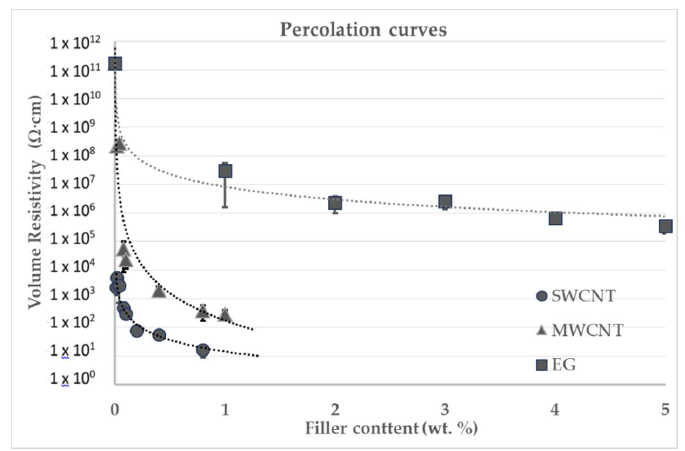
Figure 4. Electrical percolation curves of the epoxy nanocomposites prepared with the selected carbon nanomaterials.